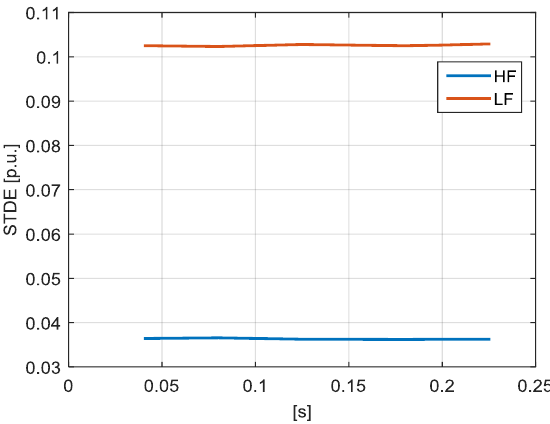
Figure 27. Case study 1: Δ STK at low-frequency (0 ÷ 2 kHz, red line) and at high-frequency (2 ÷ 150 kHz, blue line) obtained through STFT.